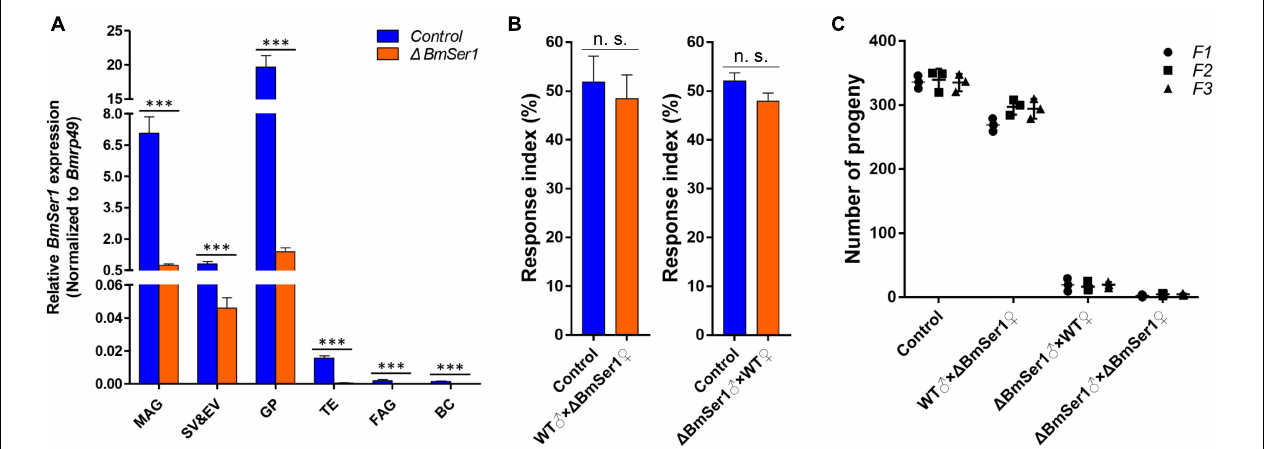
FIGURE 5 | Competitiveness and heritability of BmSer1 mutants. (A) Relative mRNA expression of BmSer1 in six reproductive tissues of virgin adults. Abbreviations: male accessory gland (MAG), seminal vesicle and ejaculatory vesicle (SV&EV), glandula prostatica (GP), testis (TE), female accessory gland (FAG), and bursa copulatrix (BC). The mRNA expression was normalized to Bmrp49 . (B) Response index of (cid:49) BmSer1 vs. WT females and males. (C) Number of progeny with indicated mutations in F1 (circle), F2 (square), and F3 (triangle) generations. The data shown are means ± S.E.M. Asterisks indicate significant differences with a two-tailed t -test: ∗∗∗ P < 0.001, n.s. no significant.